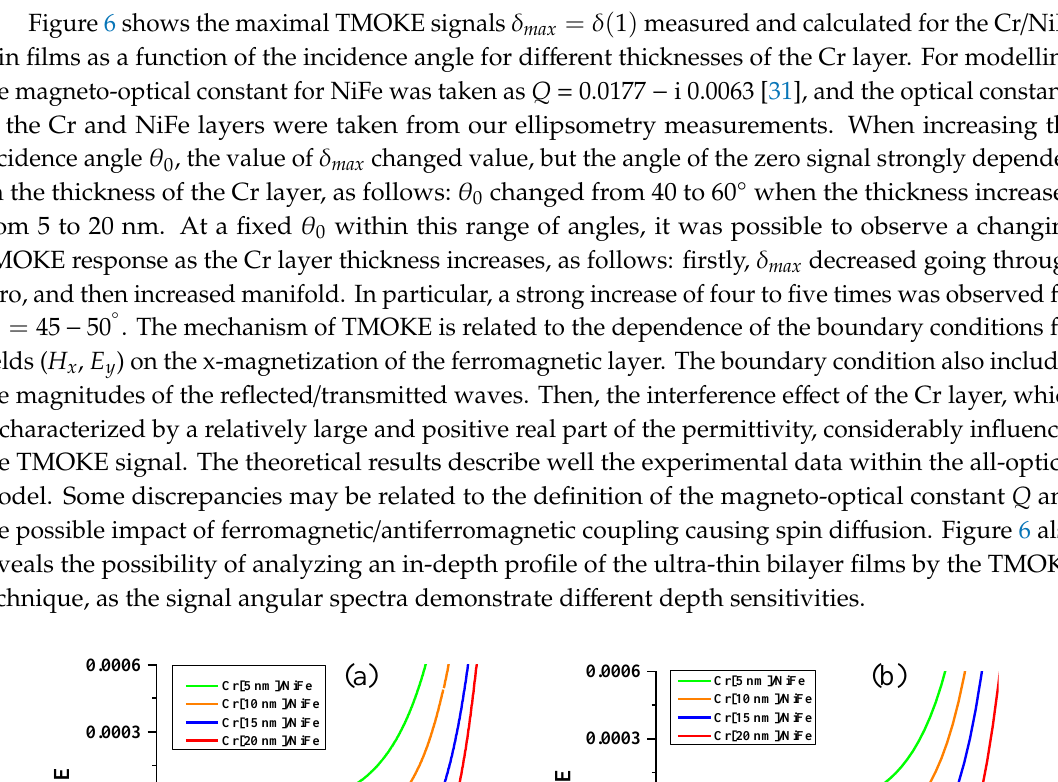
Figure 5. Reflectance parameters of p-polarized light vs. incidence angle 𝜃 0 for Cr/NiFe films with different thicknesses of the Cr layer and with the thickness of NiFe fixed to 10 nm: ( a ) experimental plots and ( b ) the theoretical plots calculated with the layer optical parameters deduced from the ellipsometry measurements.